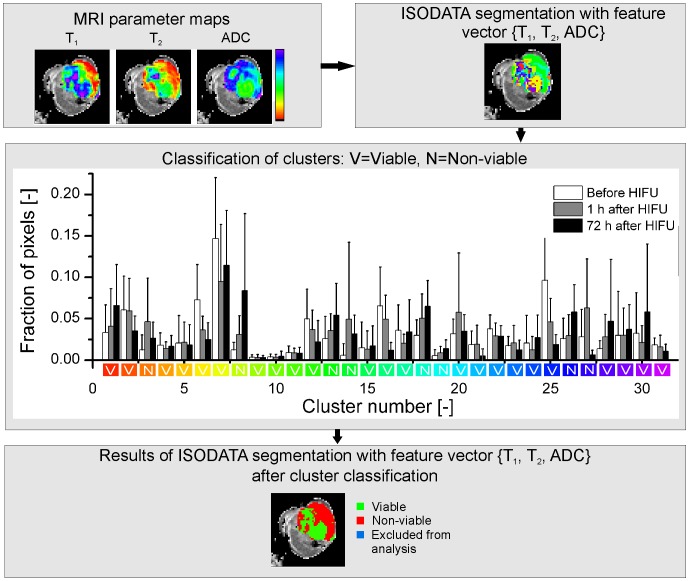
Flow chart of ISODATA segmentation.Flow chart of the classification of clusters resulting from ISODATA segmentation with feature vector {T1, T2, ADC}. MRI parameter maps were generated from the multiparametric MRI data (top left). The displayed MRI results originate from a tumor scanned at 72 h after HIFU treatment. Pixels were clustered into tissue populations with similar MRI parameters (top right; different colors represent different clusters). The resulting clusters were classified as either viable (labeled ‘V’ in the histogram) or non-viable (labeled ‘N’ in the histogram) based on the fraction of pixels assigned to the clusters at the different time points. Clusters of which the fraction of pixels had increased significantly (paired Student's t-test, p<0.05) after HIFU compared to before HIFU were assigned to non-viable tumor tissue. The remaining clusters were assigned to viable tumor tissue. The histogram of the fractions of tumor pixels in each cluster at the different time points is displayed in the center of the figure. The white, grey and black bars represent mean ± SD of the fractions of tumor pixels before, at 1 h after and at 72 h after HIFU, respectively. The color coding on the x-axis of the histogram corresponds to the cluster colors in the ISODATA segmentation results (top right). The result of the ISODATA segmentation after classification of the clusters as either viable or non-viable tumor tissue is shown in the bottom part of the figure. A small number of tumor pixels was excluded from ISODATA analysis, because of a low signal-to-noise ratio (see Methods).